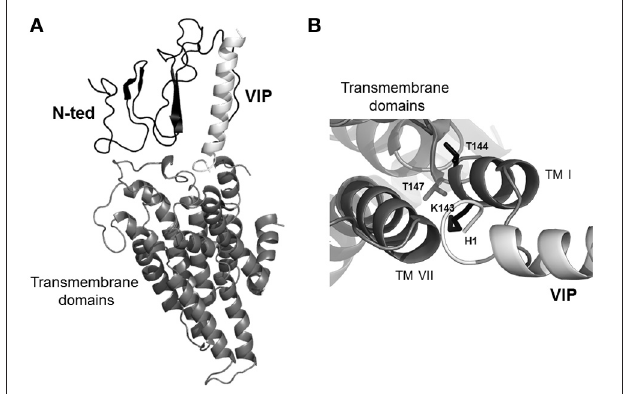
FIGURE 4 | Representation of global 3D-model of VPAC1 docked to VIP. (A) 3D-global model of human VPAC1 based on X-ray structure of the A2A receptor. (B) Upside view of 3D-global model of human VPAC1 displaying side-chains of residues of the 3D-global model of the receptor ( black sticks ) in close contact (distance < 6Å) with the N-terminal end of VIP ( white ). middle gray ribbon , transmembrane domains; black ribbon , main chain of N-ted; white ribbon , main chain of